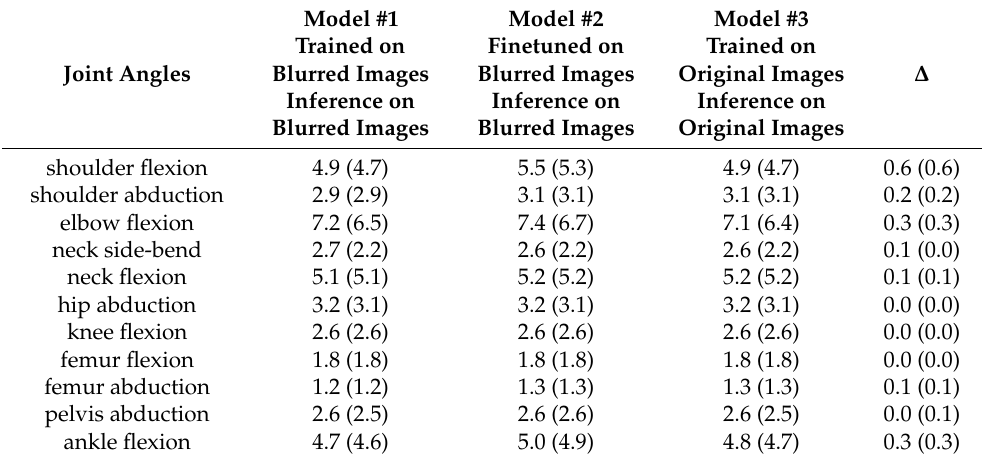
Table 3. The RMSE (+SD of all the frames) of joint angles calculated with the joints’ position from the models trained on blurred/original images ( ◦